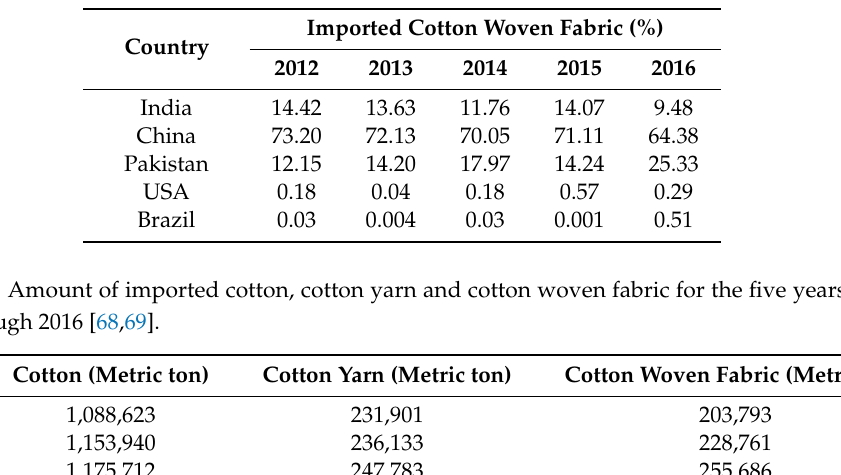
Table A3. Percentage of imported cotton woven fabric from di ff erent countries [68].